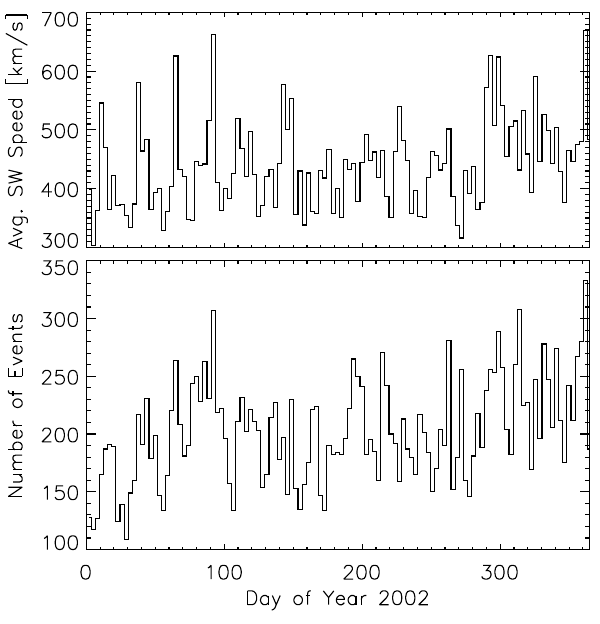
Fig. 5. Lower panel: Occurrence of events during the year 2002. Upper panel: Average solar wind speed observed by the WIND satellite. During the first 100 days of the year both data sets are apparently correlated, their maxima exhibit a periodicity of about 27 days. Histogram binning used: 3 days.